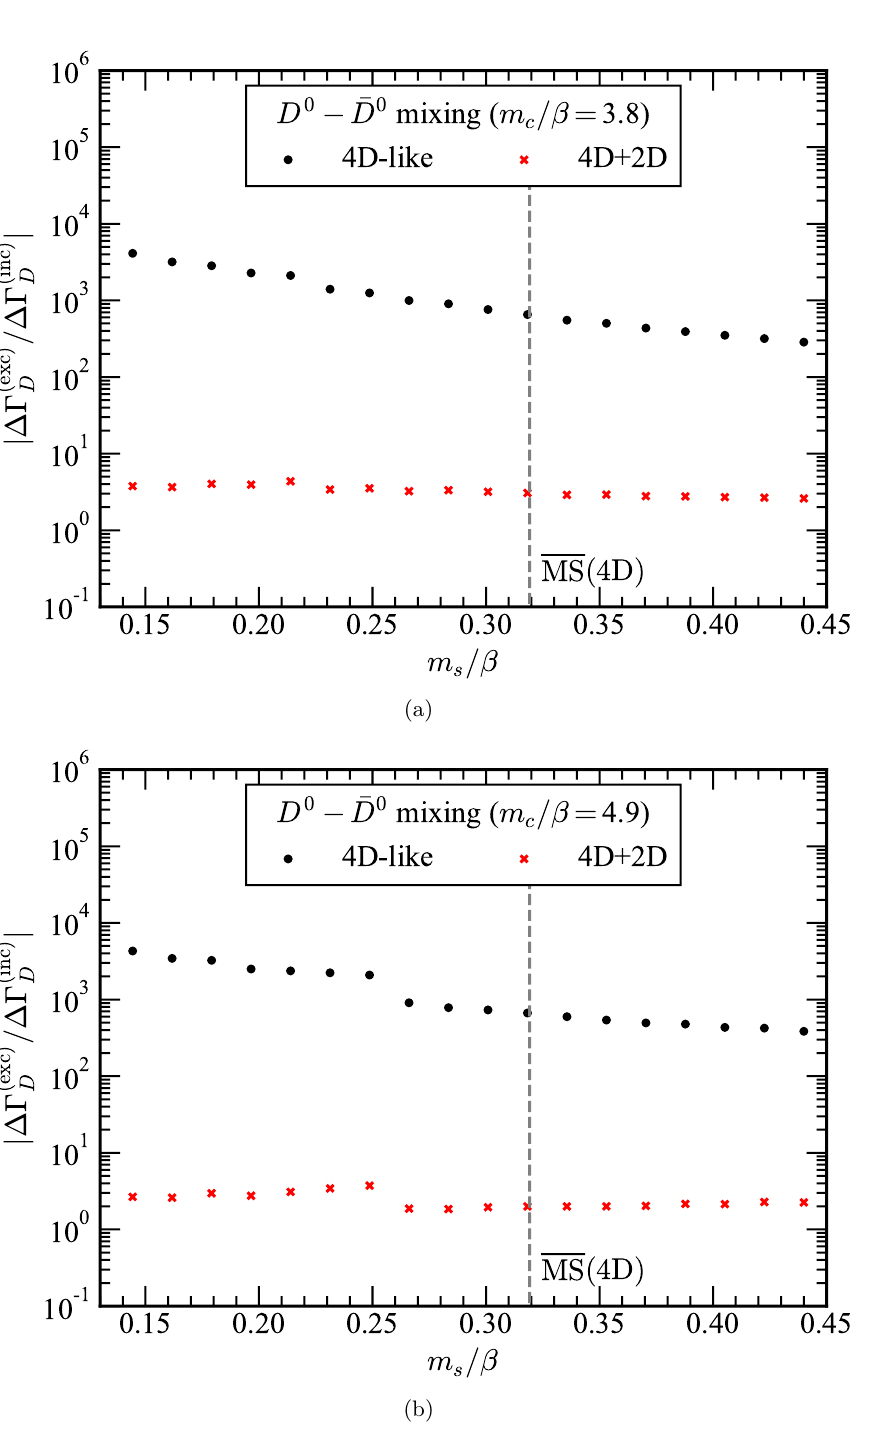
Figure 9 . Same as figure 6 for the observable width difference in the D 0 − m c /β = 3 . 8 , (b) m c /β = 4 . 9